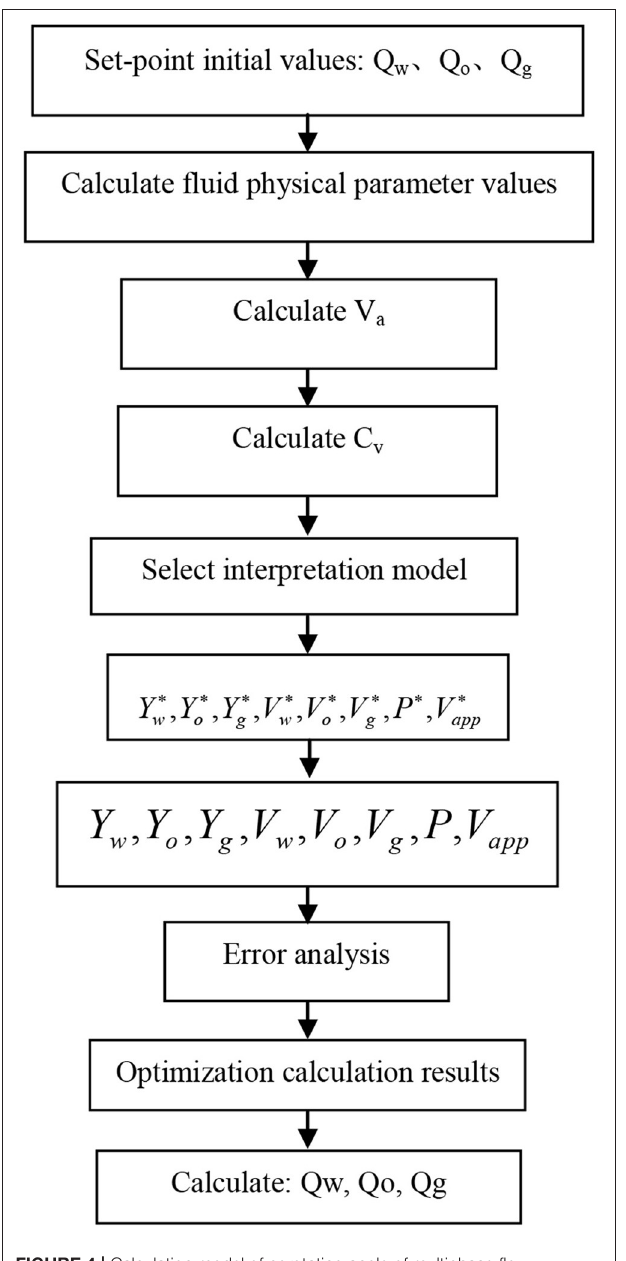
FIGURE 4 | Calculation model of corotating angle of multiphase flow.